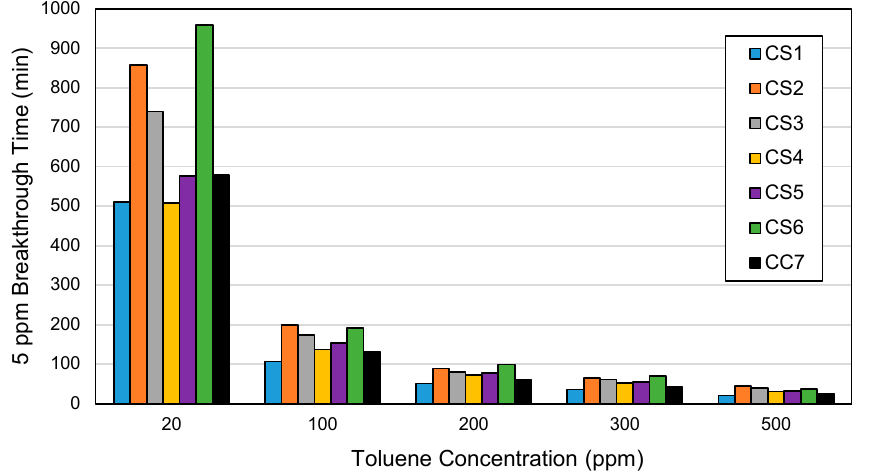
Figure 7. Toluene 5 ppm breakthrough time by cartridge type and toluene concentration. Cartridge type (ACF composition): CS1 (100% AF1); CS2 (100% AF2); CS3 (100% AF3); CS4 (100% AF4); CS5 (100% AF5); CS6 (100% AF6); CC7 (71% AF1/29% AC1).